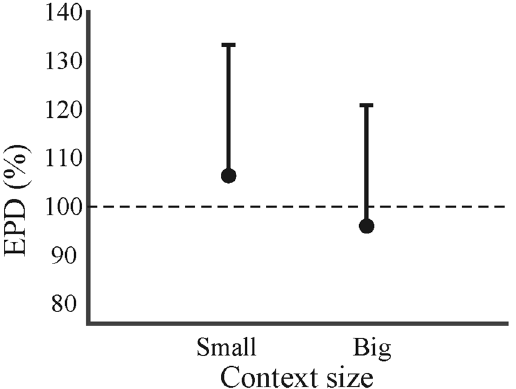
Figure 6. The endpoint distribution ( EPD ) in percentage for the small and big context, relative to the control condition. The error bars represent the standard deviation. The dotted line signifies the EPD of the control